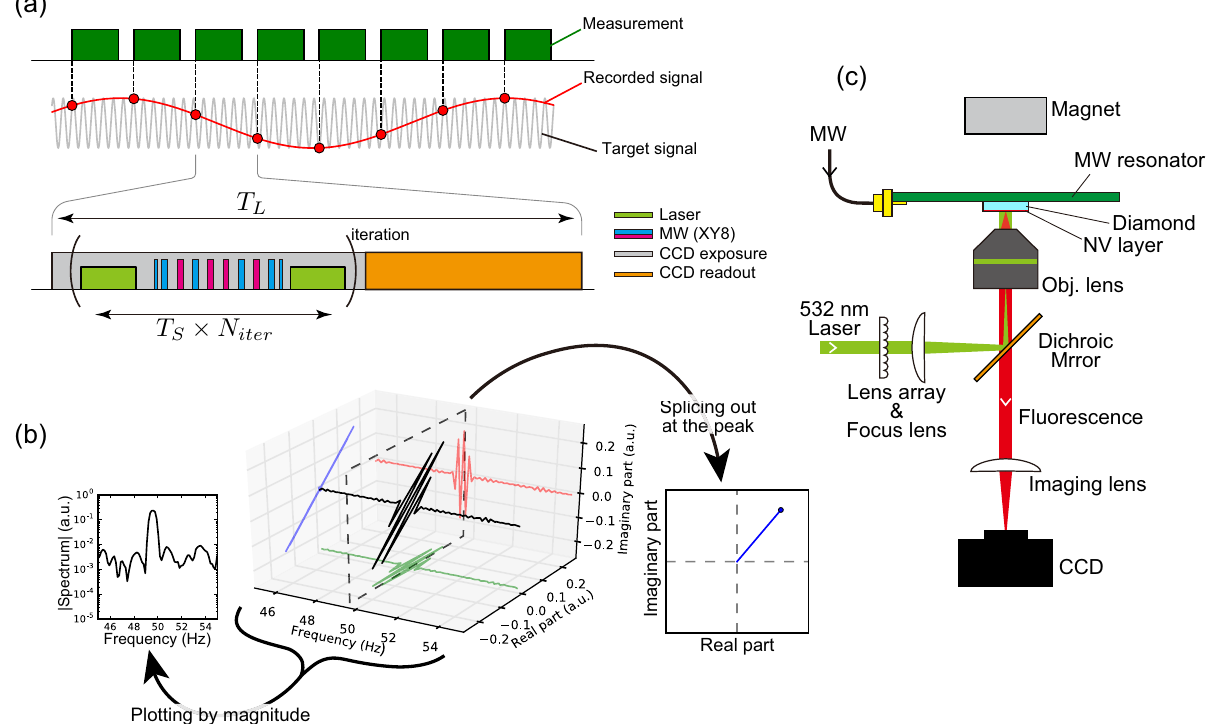
Figure 1. ( a ) Measurement protocol with sequential measurements recording the signal in undersampling. Each green represents quantum sensing iterated by N iter times and a CCD readout. ( b ) Principle of an oscillating field analysis involving the three-dimensional Fourier spectrum: frequency axis, real, and imaginary part of the Fourier coefficient. Splicing out at the signal frequency and moving to the IQ diagram, the Fourier spectrum represents the magnitude and the phase of the oscillating signal. ( c ) Overview schematic of experimental